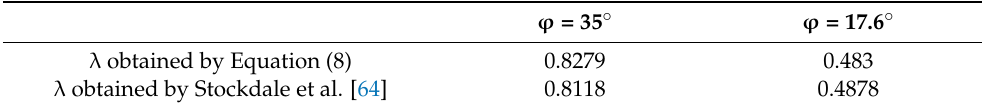
Table 2. Results obtained by Equation (8) and Stockdale et al. [64] for the simple example of Figure 11 when all the interfaces are peripheral.